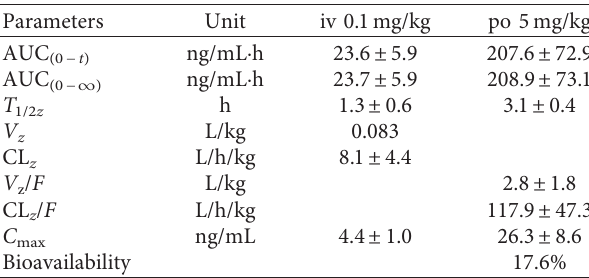
Figure 3: Plasma concentration-time curve of 10-hydroxy mesa- conitine after oral (5mg/kg) and intravenous (0.1mg/kg) administration. Table 3: Main pharmacokinetic parameters of 10-hydroxy mesaconitine in